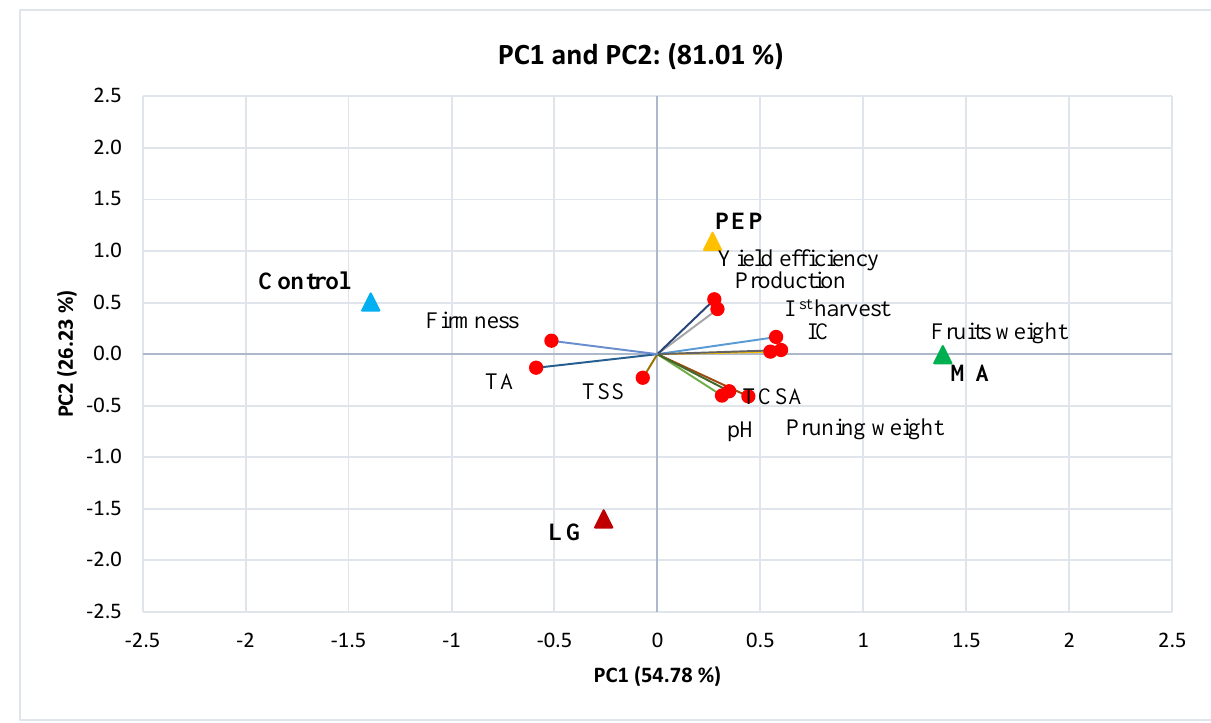
Figure 2. Principal component analysis (PCA) based on the biostimulant treatments with respect to production, fruits weight, pruning weight, I st harvest, trunk cross sectional area (TCSA), yield efficiency, total soluble solids (TSS), titratable acidity (TA), pH, firmness, and color index (CI).